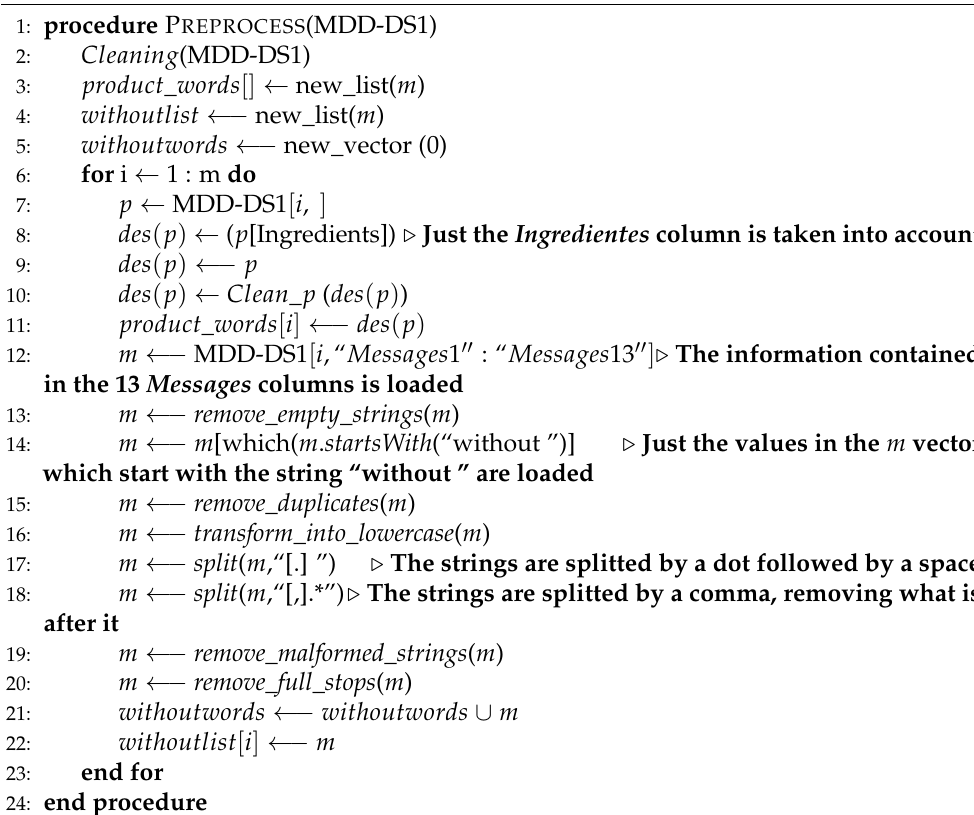
Algorithm 2 RS-CF: HTH-BD: Preprocessing